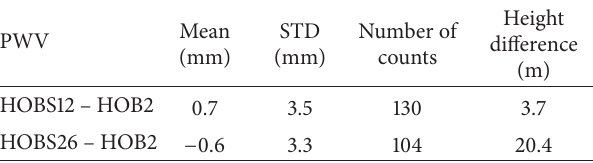
Figure 4: Histograms of PWV differences between VLBI and GPS estimates. Table 5: Mean and standard deviation (mm) of the differences between VLBI and GPS derived PWV